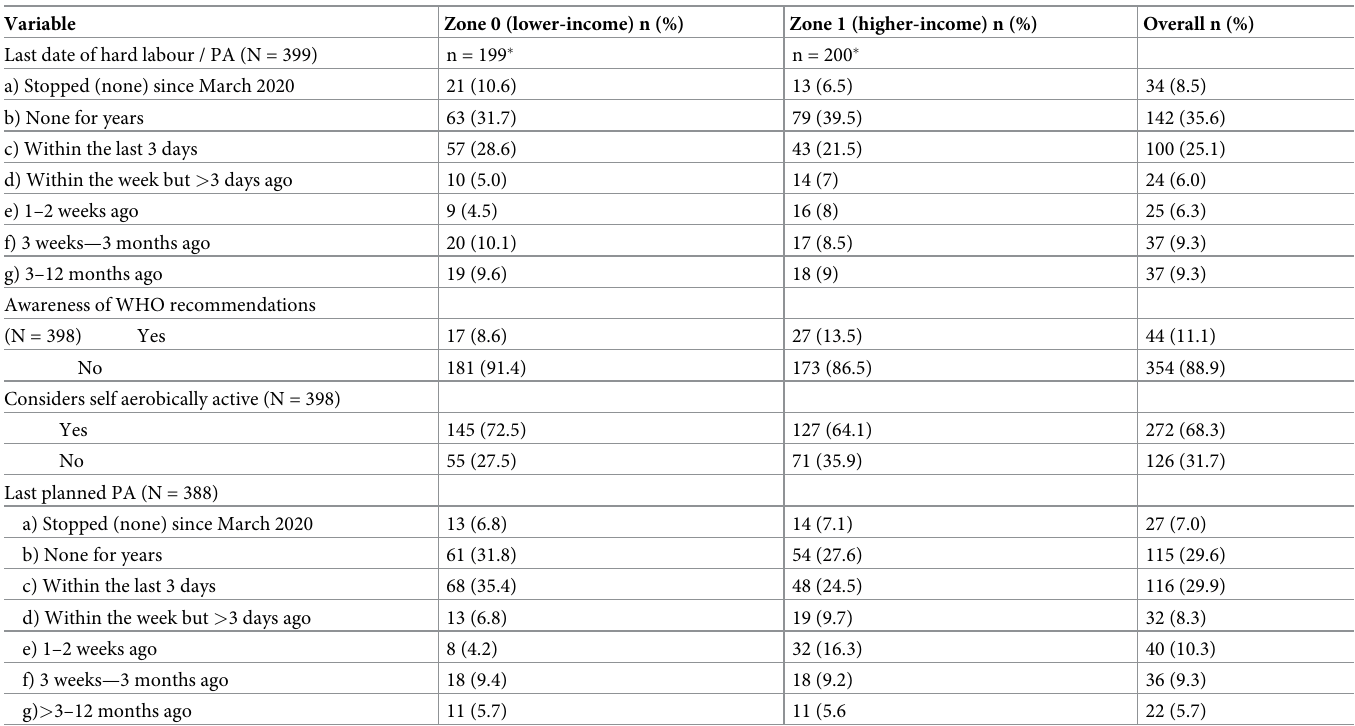
Table 2. Physical activity history and